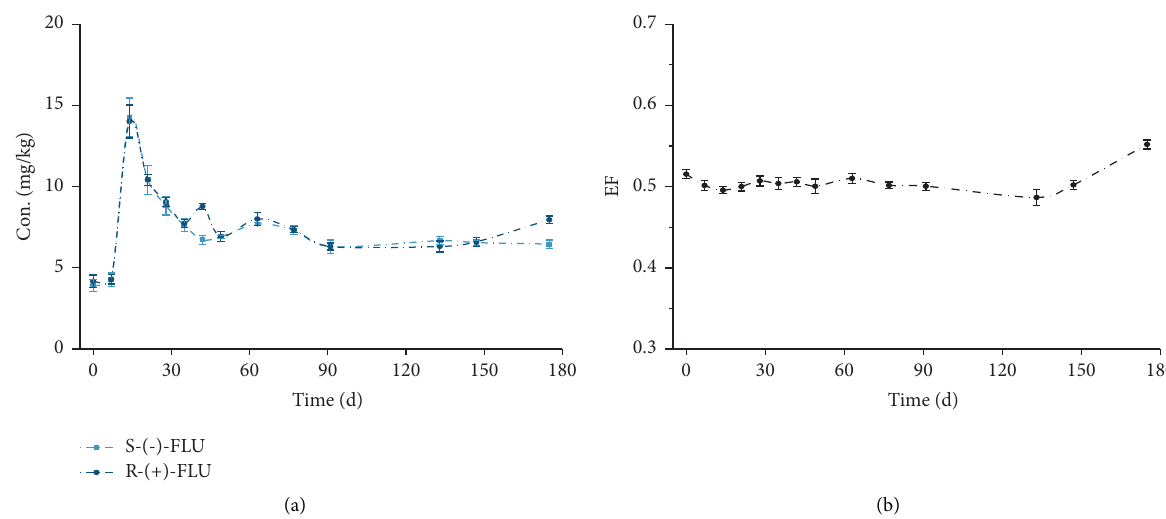
Figure 5: Temporal changes of FLU enantiomers in the bottom sediment of the tank system. Te points and error bars represent the mean and standard deviation of replicates, respectively ( n � 4).